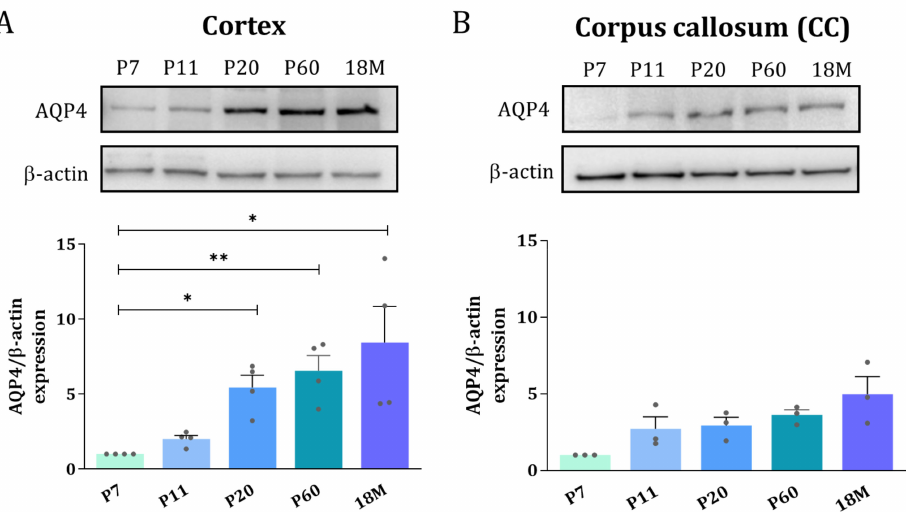
Figure 3. Adult brain undergoes an AQP4 protein increase in the cortex but remains at the same protein levels in corpus callosum. Western blot analysis of AQP4 protein amount at different age groups was performed in the cortex ( A ) and corpus callosum ( B ). Data shown are representative for 3 independent experiments. n = 3–5 animals per group. Mean values are represented with the standard error of the mean (SEM). Statistically significant differences between mean values were assessed by ANOVA test with post hoc TUKEY multiple comparison test (* p < 0.05, ** p <